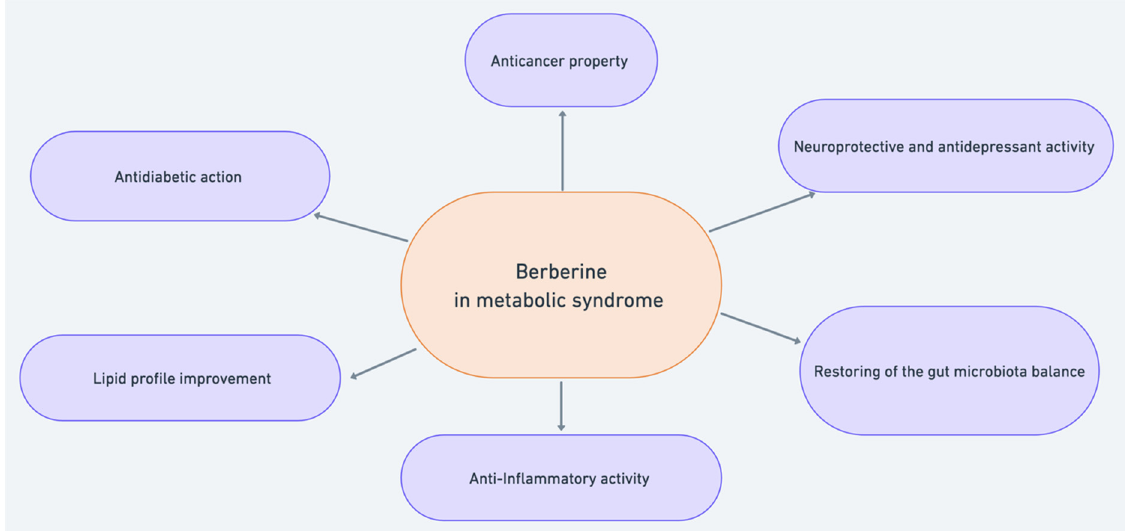
Figure 2. Potential berberine activity against the metabolic syndrome.